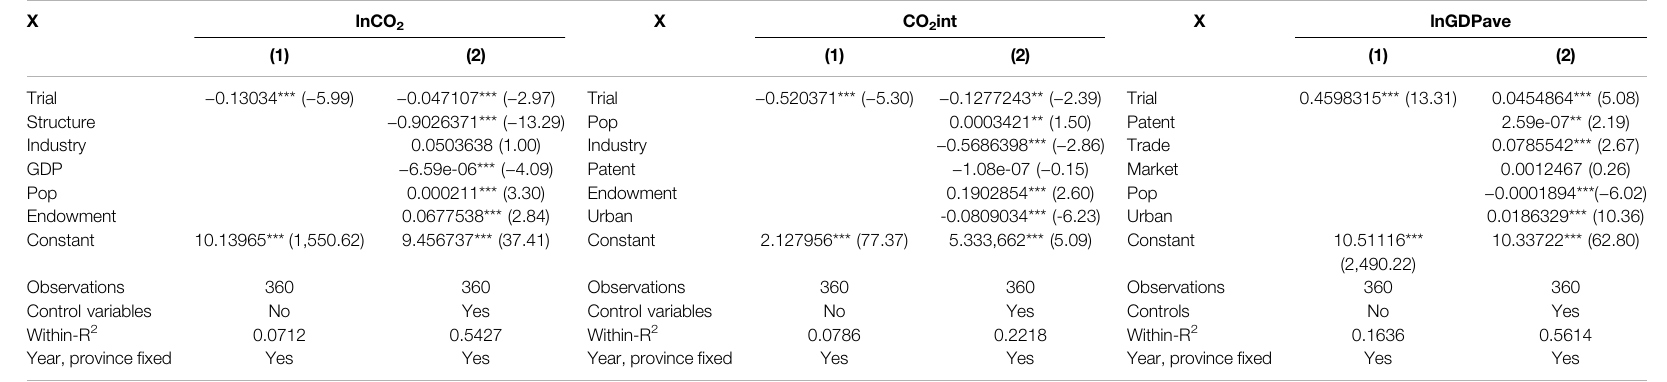
TABLE 4 | DID regression results.